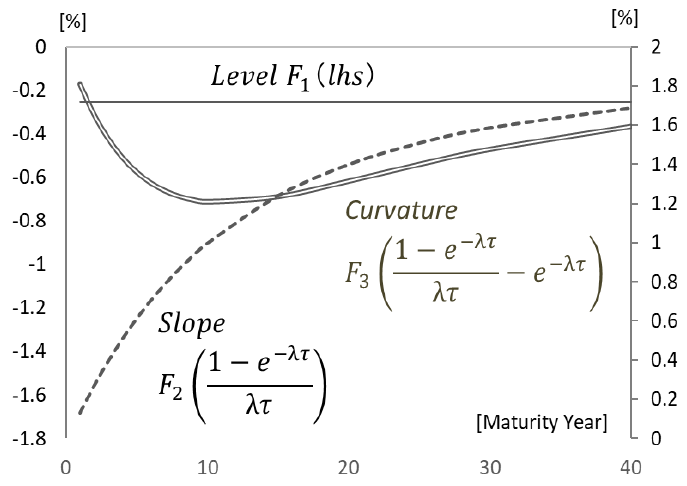
Figure 4. Three factors of the Nelson–Siegel model.